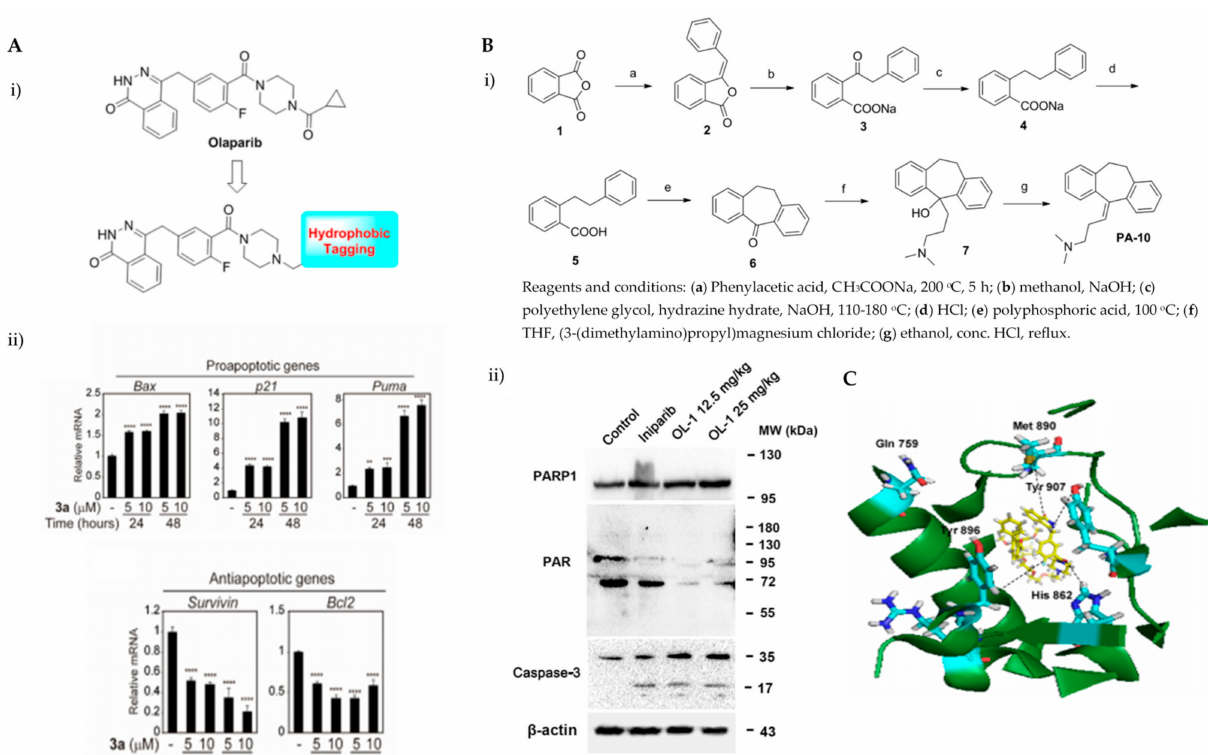
Figure 3. ( A ). ( i ) The strategy used to develop small molecule 3a, a PARP hydrophobic tagged-molecule. ( ii ) The expression of proapoptotic and antiapoptotic target genes measured using quantitative RT-PCR in TNBC cells treated with either vehicle or small molecule 3a at indicated times. **** p < 0.001. ( B ). ( i ) The general synthesis of compound PA-10 (3-(10,11- dihydro-5 H -dibenzo[a,d] [7]annulen-5-ylidene)- N,N -dimethylpropan-1-amine), the lead compound used to synthesize OL-1. ( ii ) Western blot analysis of PARP, PAR and caspase-3 in tumour tissues excised from the MDA-MB-436 xenograft treated with PBS, Iniparib (100 mg/kg/d), low dose (12.5 mg/kg/d) and high dose (25 mg/kg/d) of OL-1. ( C ). Binding of conjugate 3 in the C-terminal catalytic domain of PARP1, obtained from molecular docking studies. Best pose of conjugate 3 (yellow sticks) forming hydrogen bond interactions (dotted lines) with key amino acid residues (cyan sticks) in NI, PH, and AD sites. PARP1 is shown as green ribbon. Figure 3A was reprinted with permission from Ref. [26]. Copyright (2020) European Journal of Medicinal Chemistry. Figure 3B was reprinted with permission from Ref. [27]. Copyright (2016) Springer Nature. Figure 3C was reprinted with permission from Ref. [28]. Copyright (2019) ACS